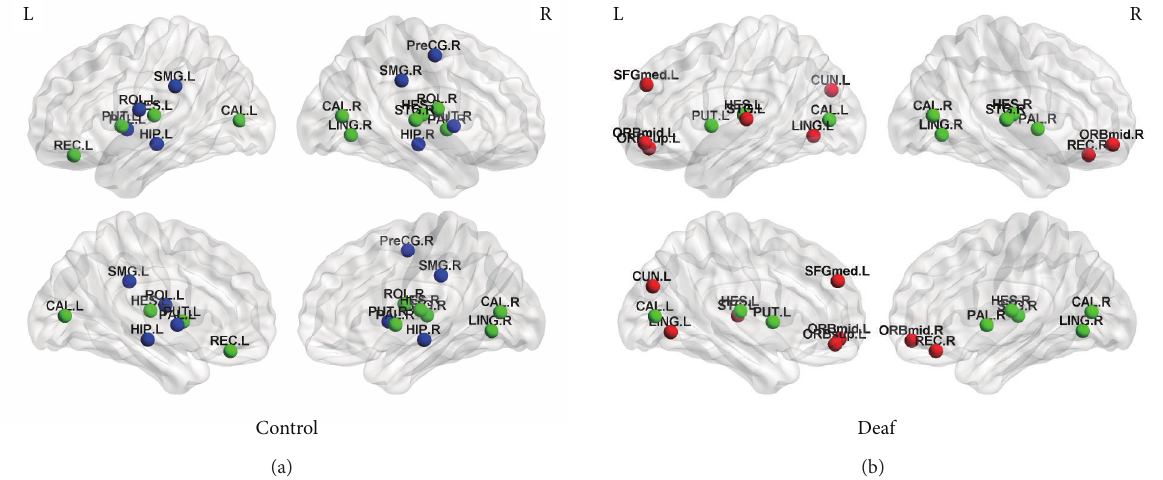
Figure 6: Hubs for brain functional networks in control (a) and deaf (b) groups. The hubs identified in both groups are shown in green color. While the hubs for the control group only are present with blue color, the hubs for the deaf group only are shown in red color.